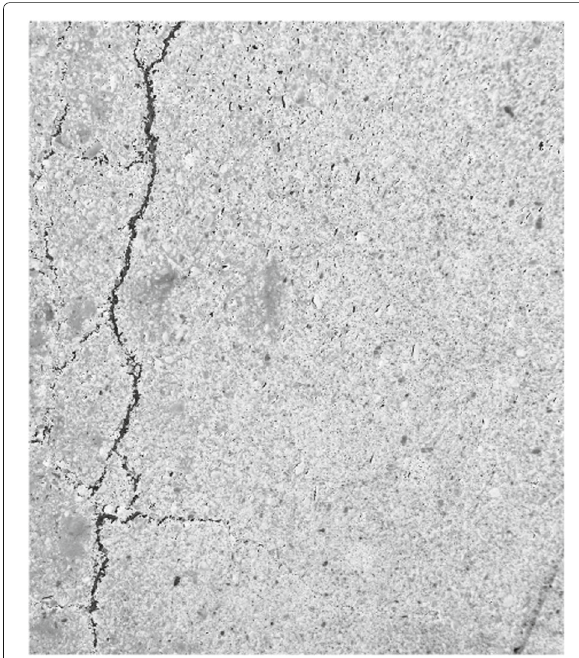
In conventional linear filtering, a constant mask is used in the whole domain taking into account Euclidean dis- tance to the central pixel (called Domain filter ). The main contribution of bilateral filtering is using an additional not linear mask which measures intensity variations with central pixel ( range filter ). Domain filter is defined as a Gaussian filter, which